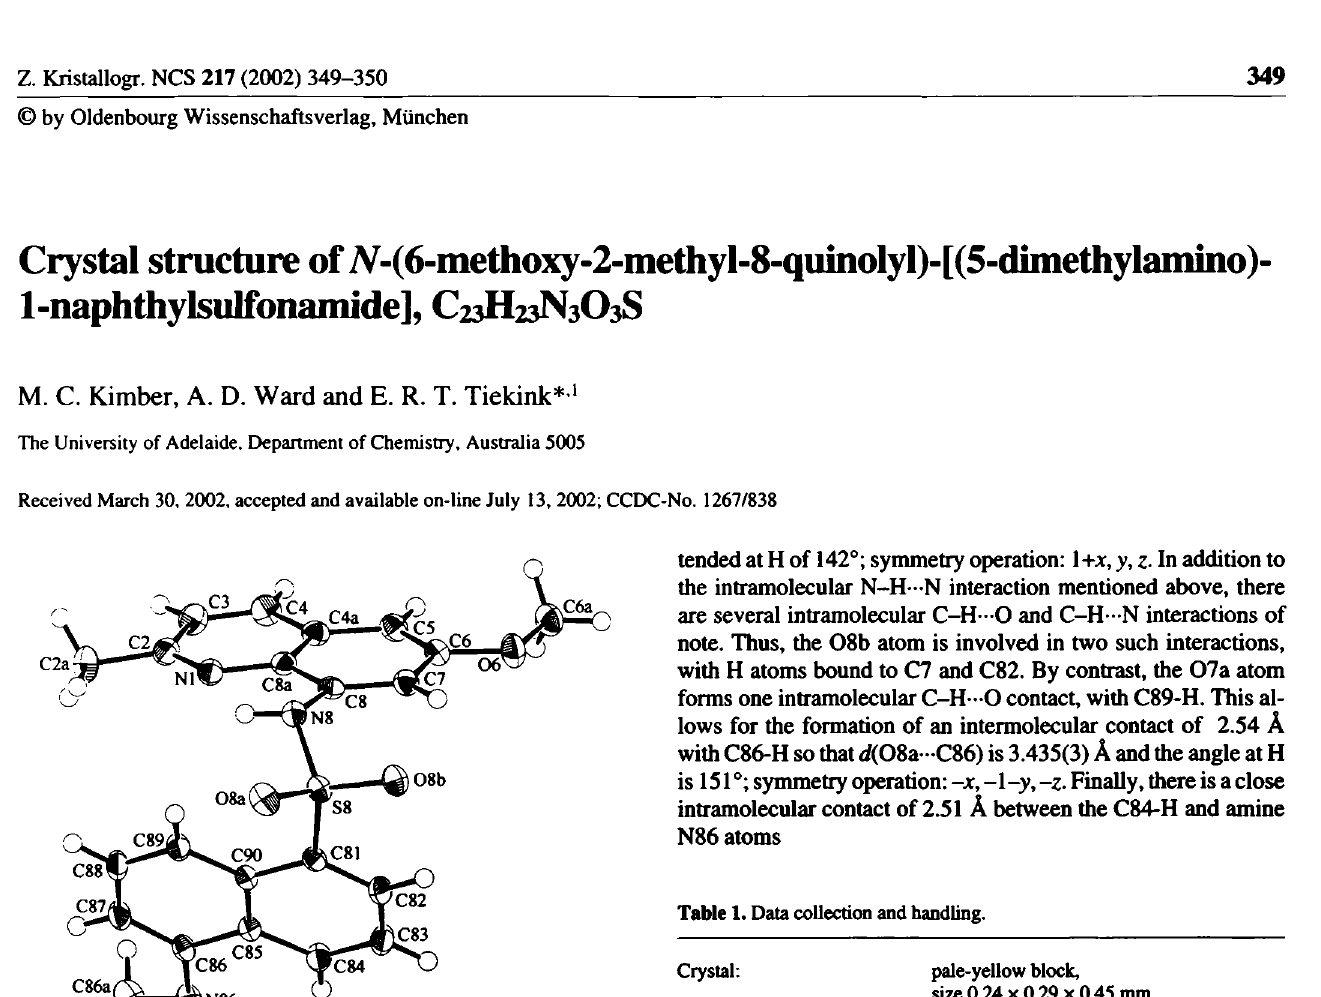
Table 1. Data collection and handling.